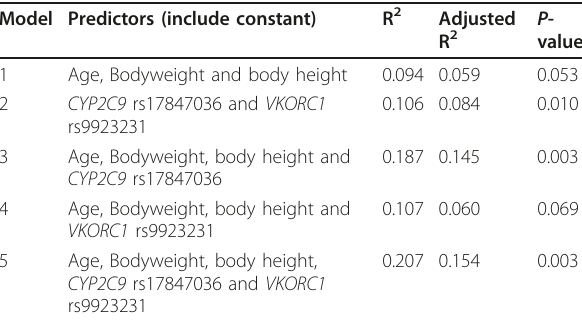
Table 4 Multiple linear regression for estimation of warfarin daily dose requirements based on age,